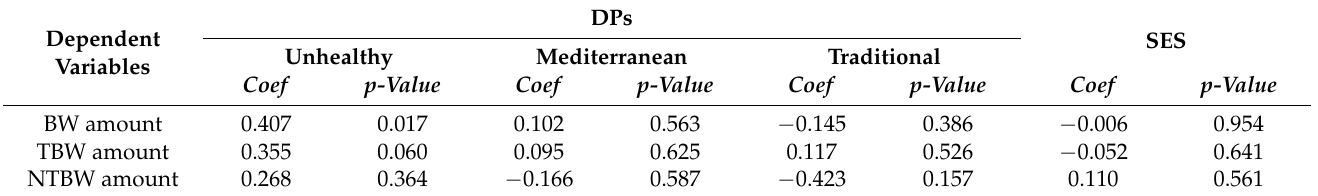
Table 5. Multiple linear regression coefficients and significances for predicting the HBW